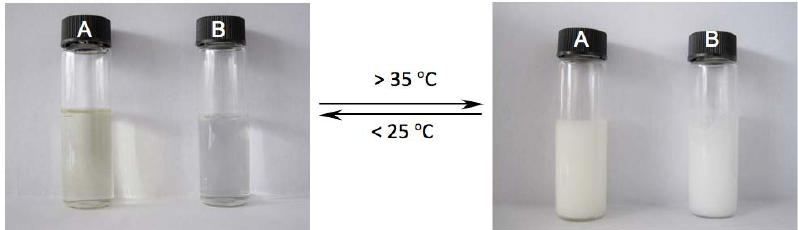
Figure 3. The thermoresponsive performance of N water solution with polymer concentration 2 w.t.%.